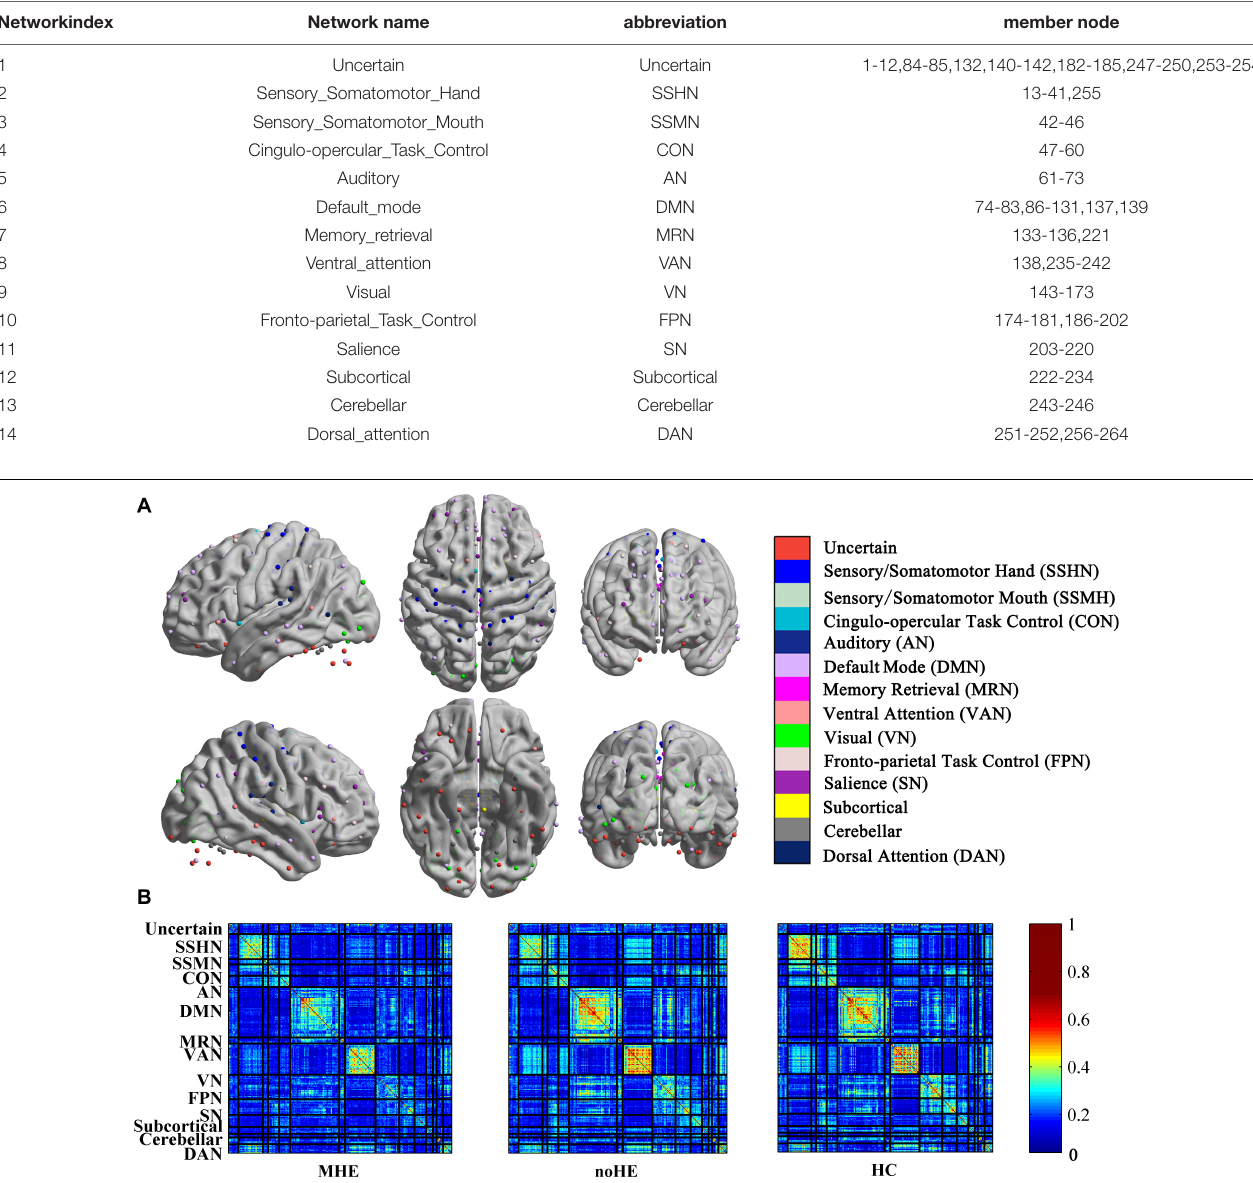
TABLE 2 | The mapping between network names, their abbreviations and member nodes.